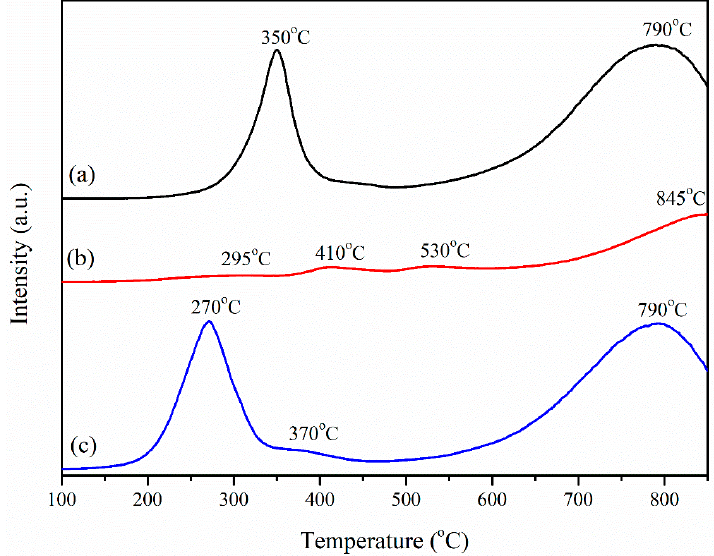
Figure 4. H 2 -TPR profile of 10Ni/MA (a), 5Ni5Ce/MA (b), and 5Ni5Co/MA (c) catalysts.